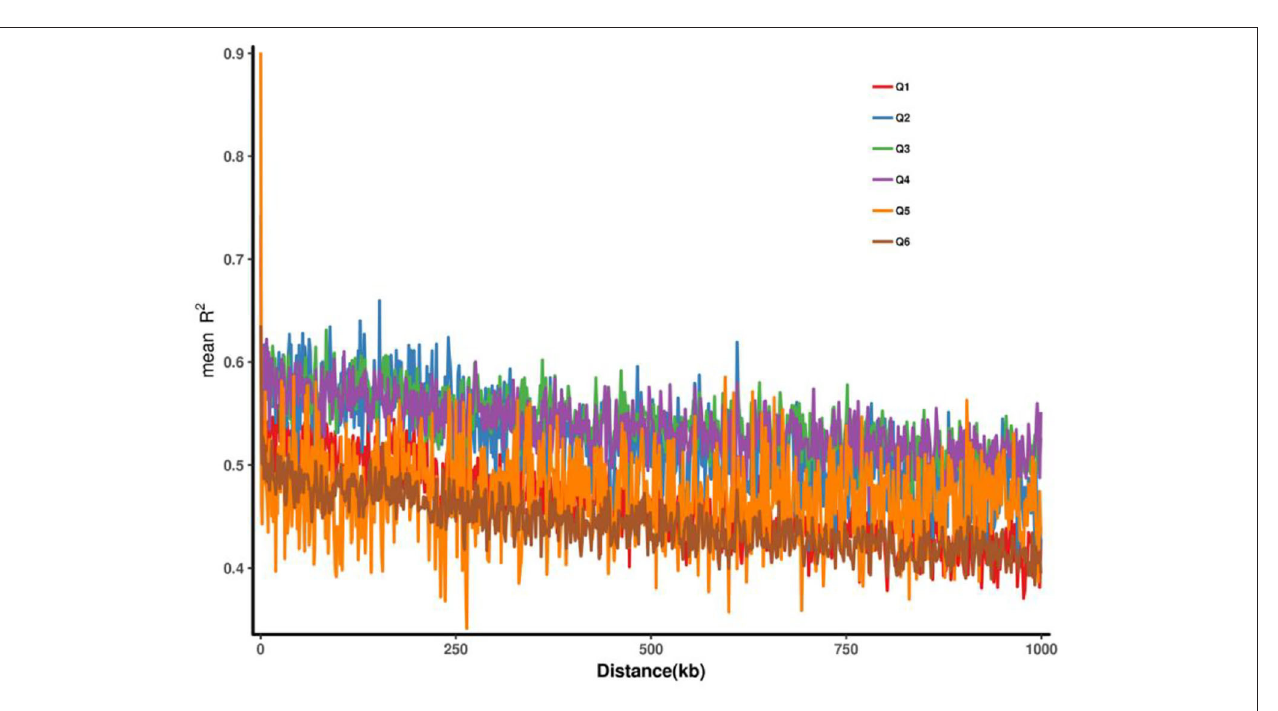
FIGURE 4 | Linkage disequilibrium decay based on six